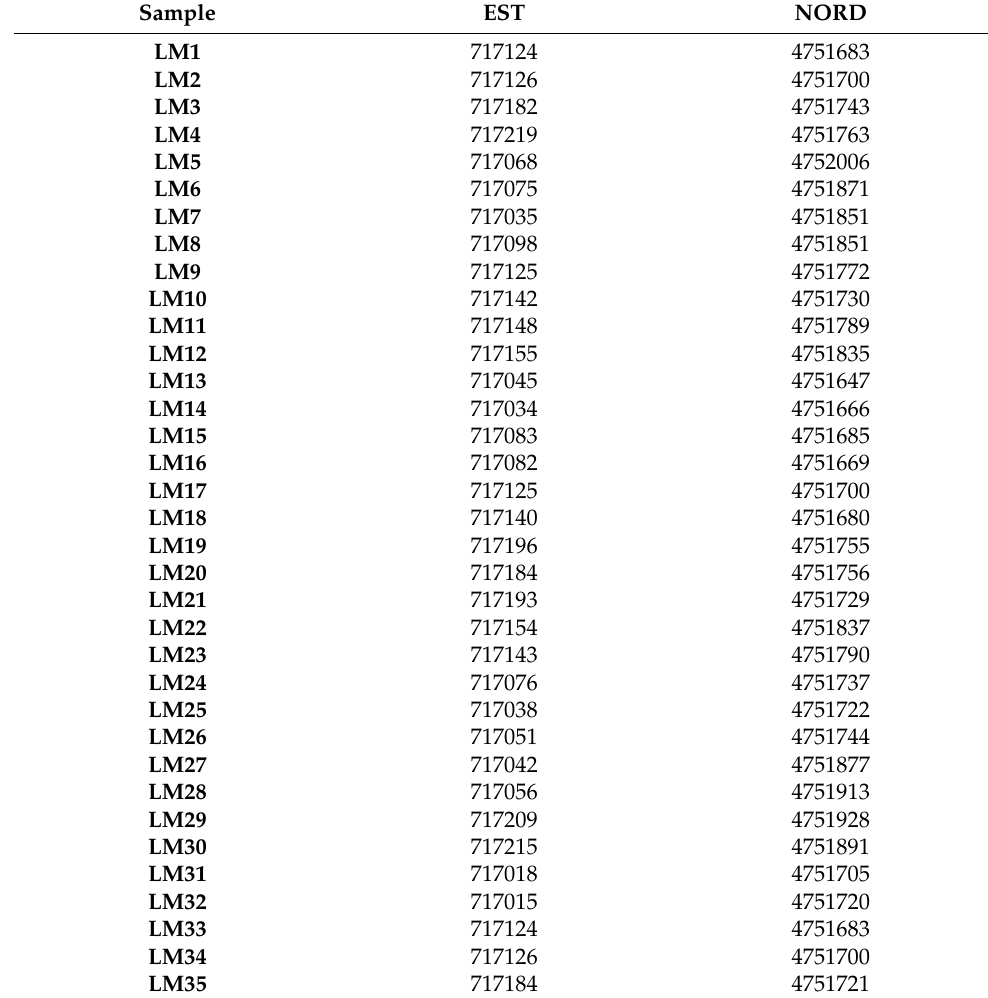
Table 1. Geographical coordinates of the sampling